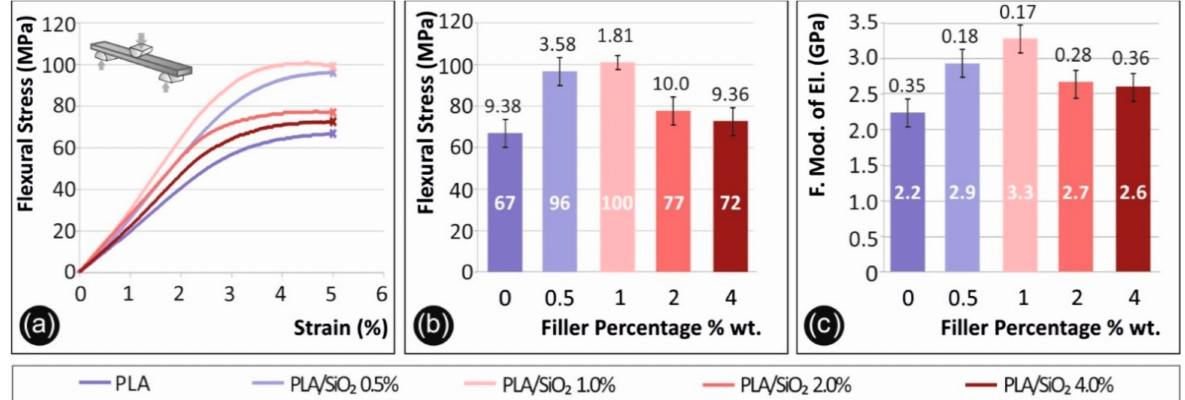
Figure 4. Flexural test results, ( a ) flexural stress (MPa) to strain (%) graph of a representative specimen of each material tested, ( b ) mean max measured flexural stress (at break) (MPa) to filler percentage (%) (0.5% wt. developed 44.1% increased values, when compared to pure PLA, 1% wt. 51.0% increase, 2% wt. 15.9% increase and 4% wt. 8.7% increase, respectively), ( c ) mean flexural modulus of elasticity (MPa) to filler percentage (%) (0.5% wt. developed 30.9% increased values, when compared to pure PLA, 1% wt. 46.6% increase, 2% wt. 19.3% increase and 4% wt. 16.4% increase, respectively).